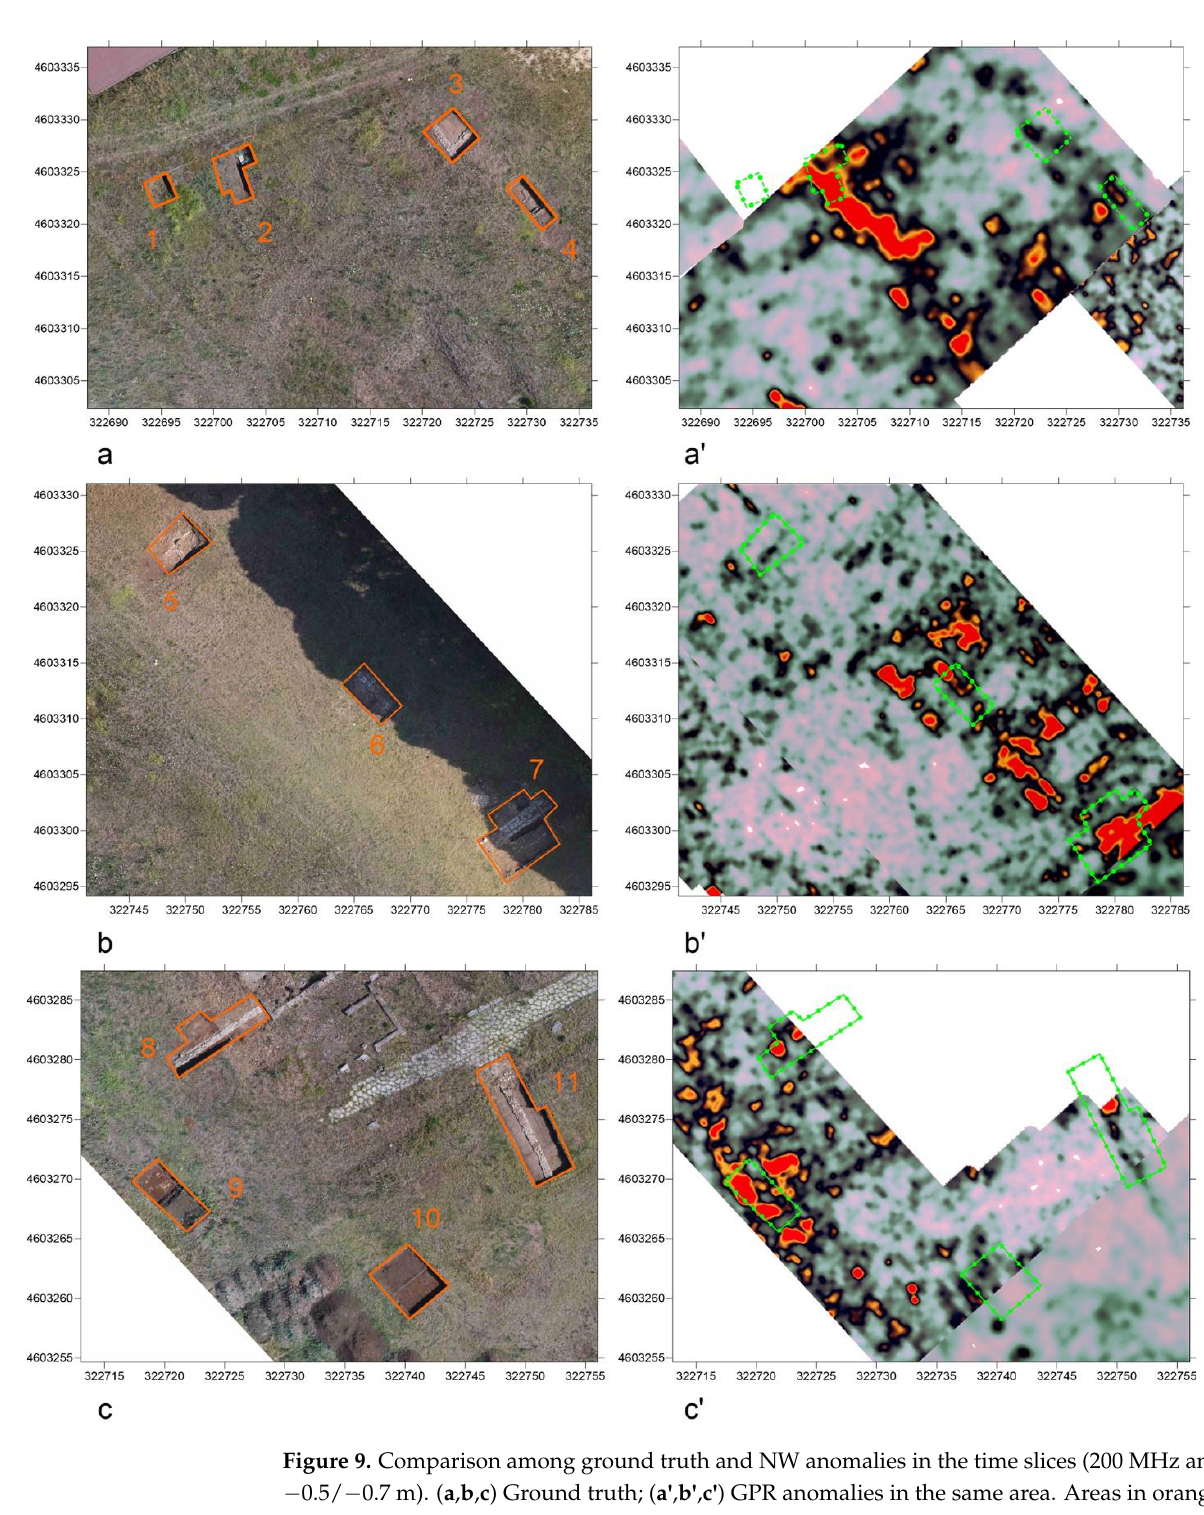
Figure 9. Comparison among ground truth and NW anomalies in the time slices (200 MHz antenna − 0.5/ − 0.7 m). ( a , b , c ) Ground truth; ( a' , b' , c' ) GPR anomalies in the same area. Areas in orange and green correspond to areas traced with GNSS prior to excavation.